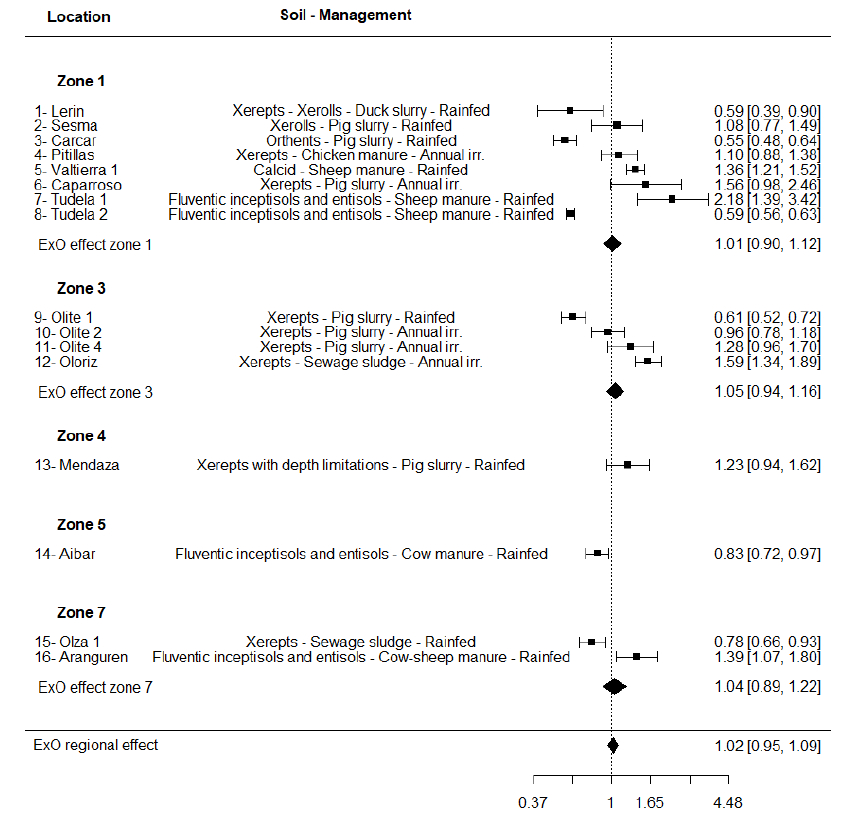
Figure 13. Response ratio (RR) of AWHC (0–30 cm) for the adaptive management strategy of exogenous sources of organic C addition (ExO). Zones correspond to those in Figure 1. The effect was considered significant when the 95% confidence interval (CI) of the RR did not overlap one ( α = 0.05). Soil and management column includes information about principal soil group, organic source applied and irrigation regime in each group.